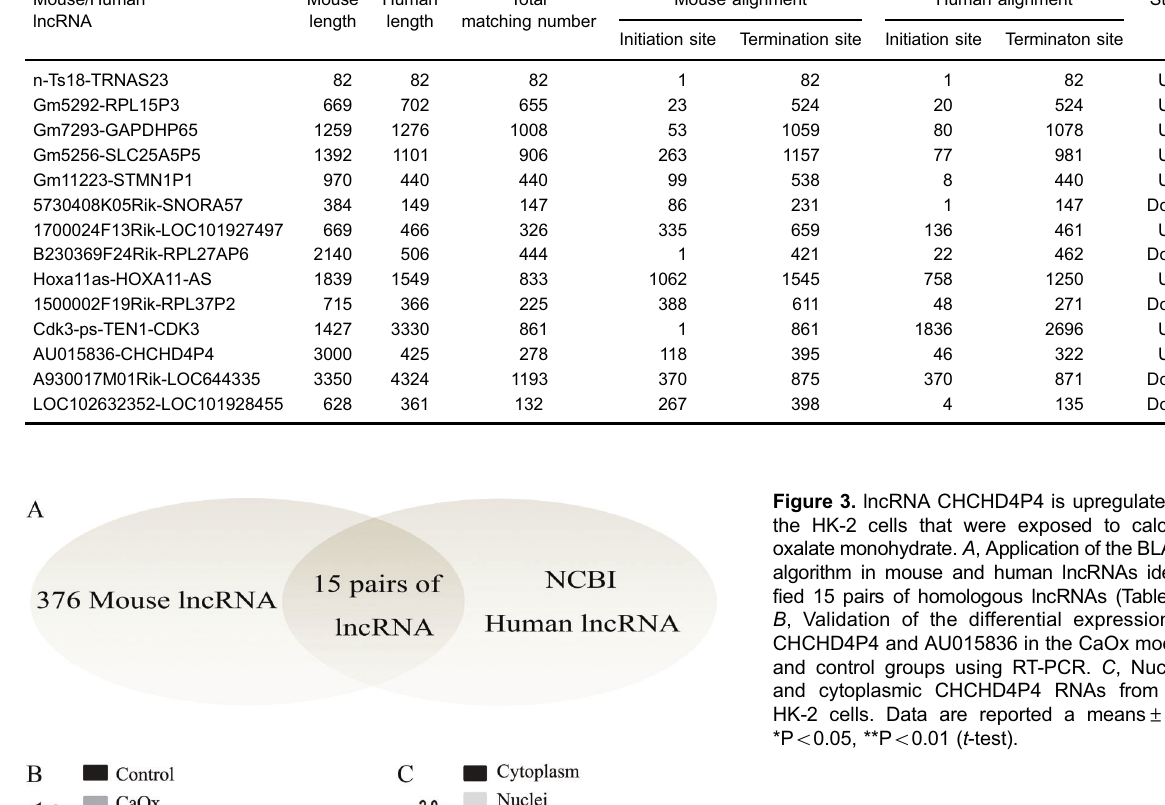
Table 2. Fifteen pairs of homologous long non-coding RNAs (lncRNAs). Mouse/Human Mouse Human Total Mouse